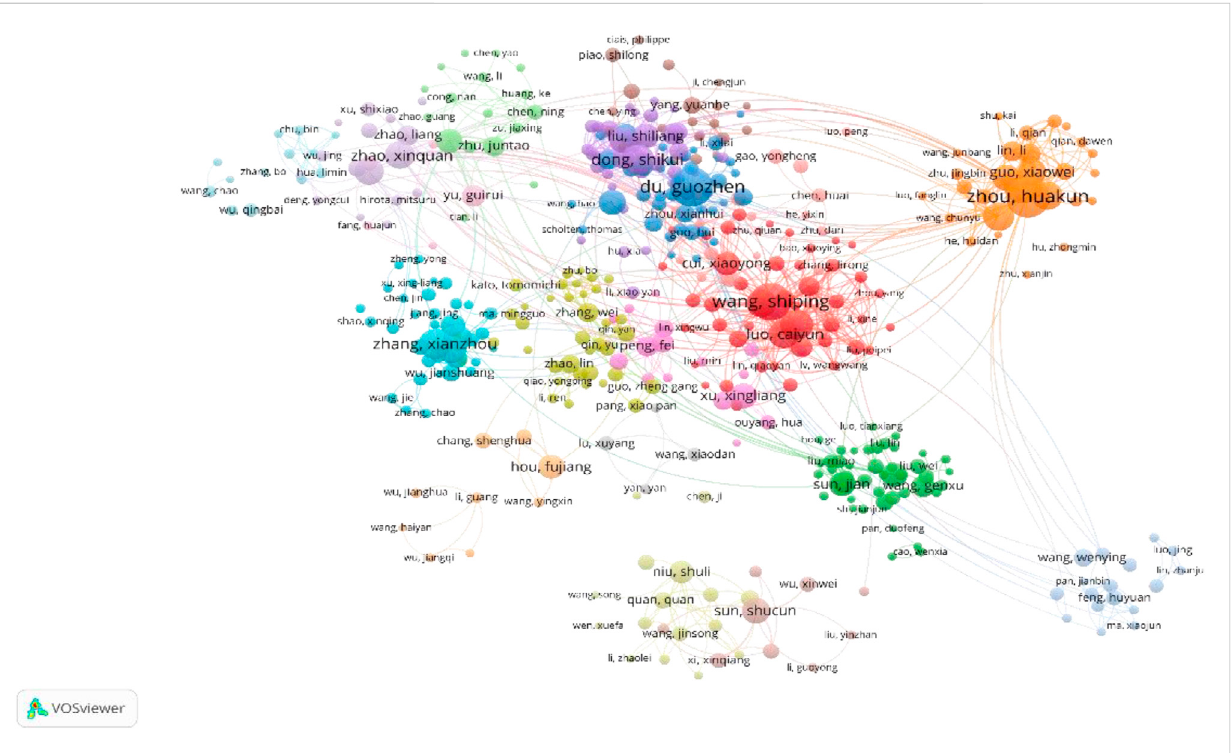
FIGURE 10 Network analysis of authors of co-cited